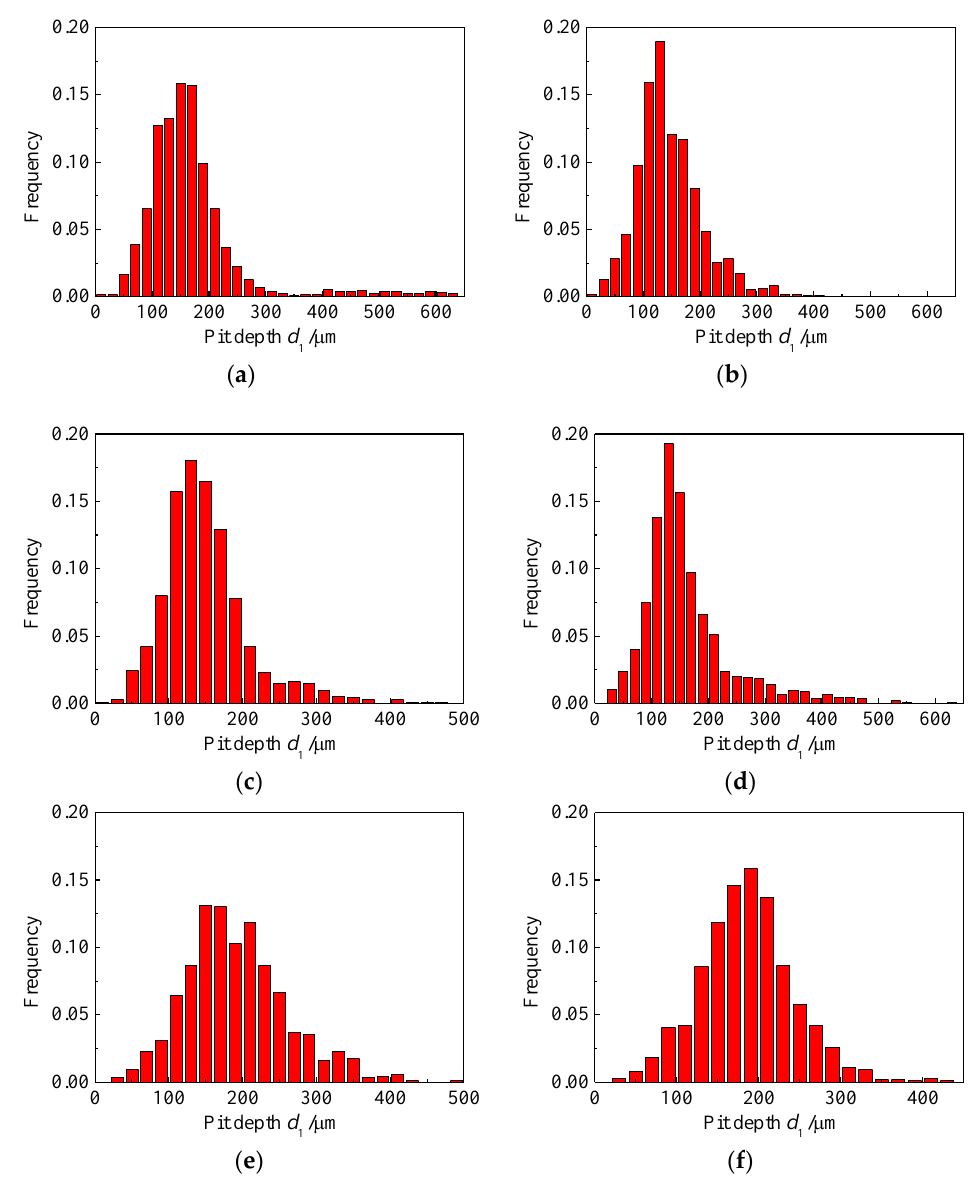
Figure 8. Frequency distributions of pit depths of corroded steel plates with different corrosion durations: ( a ) C3, ( b ) C4, ( c ) C6, ( d ) C8, ( e ) C12, ( f ) C15.